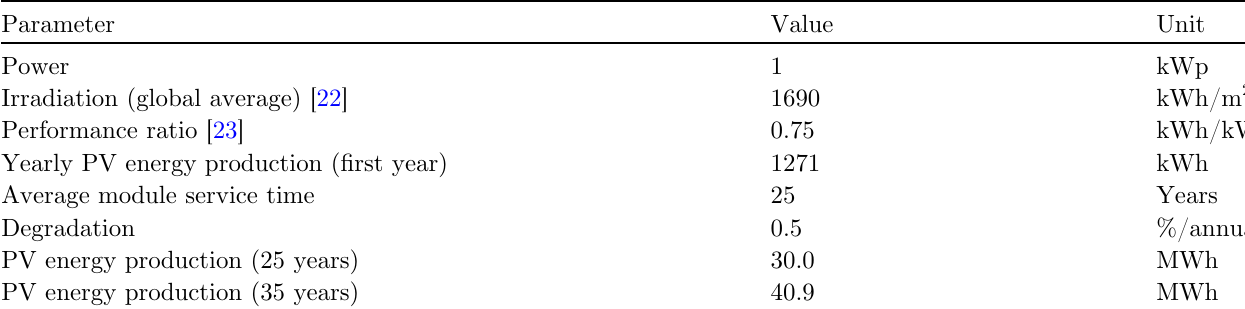
Table 1. Technical details related to functional